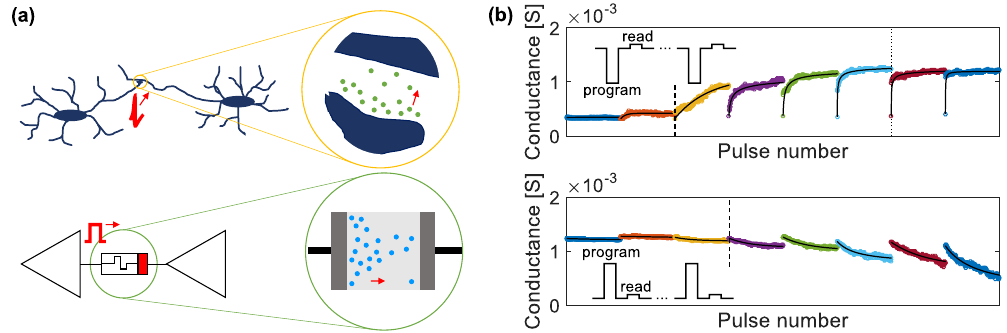
Figure 1. ( a ) Schematic analogy between ionic motion in a biological synapse (e.g. Na + , Ca 2 + ions), in between two neurons, and in an RRAM device (e.g. metal or oxygen ions) connecting two electronic neuron units. ( b ) Examples of conductance series of potentiation (top) and depression (bottom) operations obtained for 300 identical pulses with Δ t = 10 μ s. Each colour corresponds to a different series of 300 pulses starting from a similar initial state and operated with increasing absolute potential between 0.55 V (left) and 0.9 V (right) with a step of 50